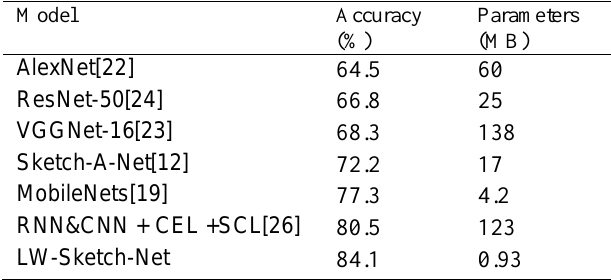
Table 6. Recognition accuracy on QuickDraw datasets